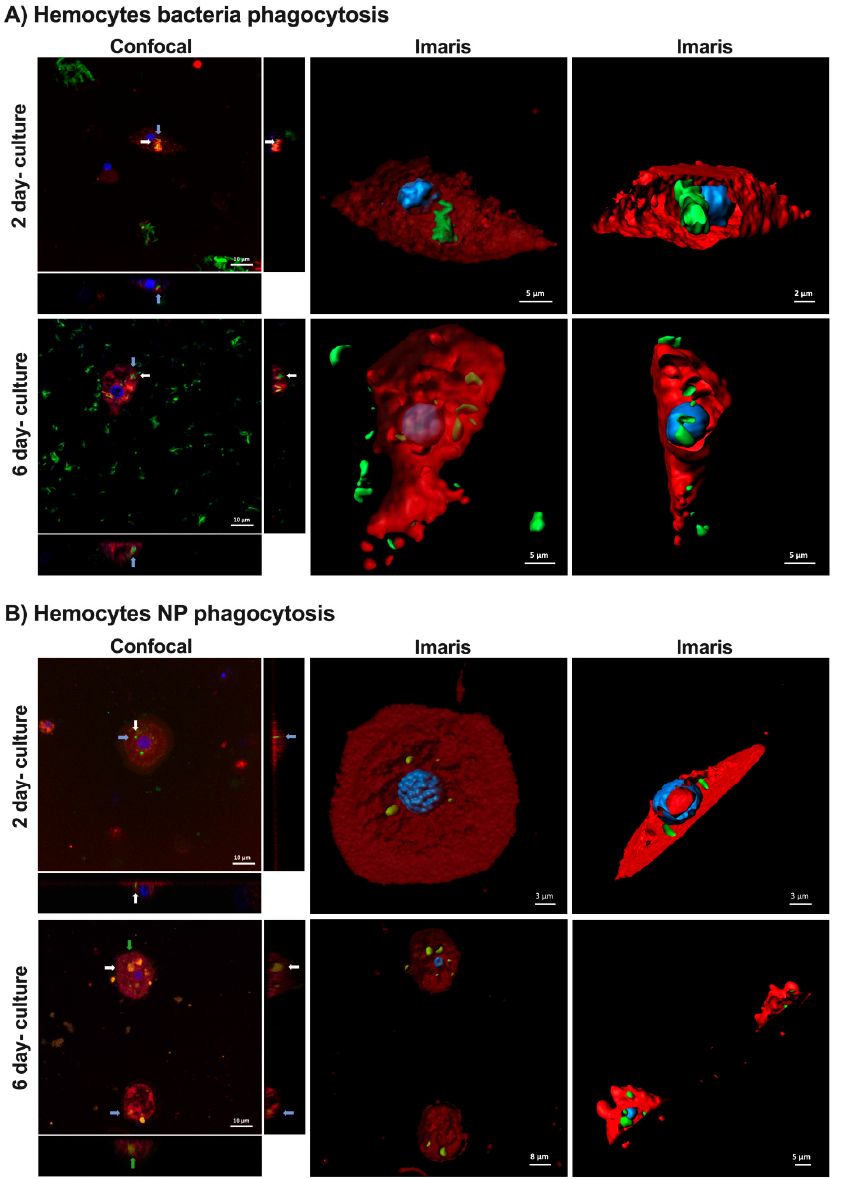
Figure 7 . Hemocyte phagocytosis of bacteria and nanoparticles in 2- and 6-day cultures. ( A ) Hemocytes (cells in red with blue nuclei) with phagocytosed bacteria (green) in both the confocal and Imaris reconstruction images. ( B ) Hemocytes (cells in red with blue nuclei) with phagocytosed nanoparticle aggregates (green) in both the confocal and Imaris reconstruction images. The same nanoparticle in the orthogonal and sumstack view is shown with the same arrow color.